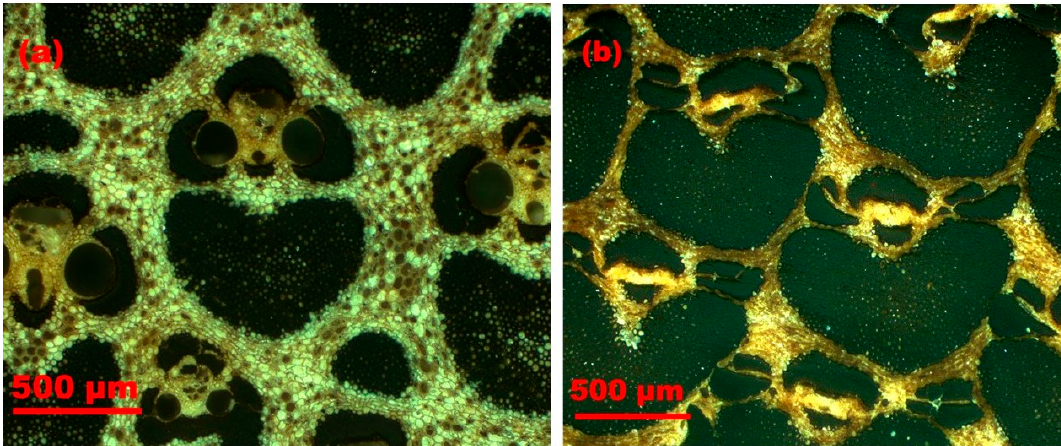
Figure 19. Optical microscope images ( a ) before densification and ( b ) after densification.